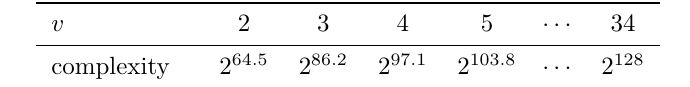
Table 3: Complexity for receiving a v -collision for a 128-bit session key k 2